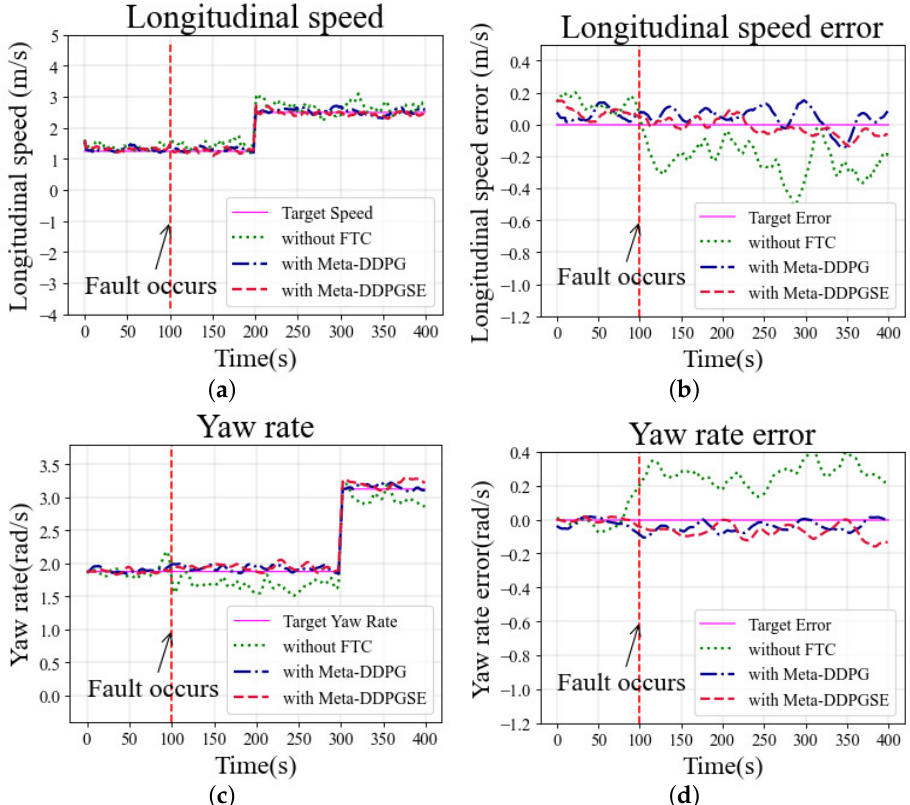
Figure 11. Simulation results in the cornering scenario with fault F ∗ gitudinal speed error; ( c ) Yaw rate; ( d ) Yaw rate